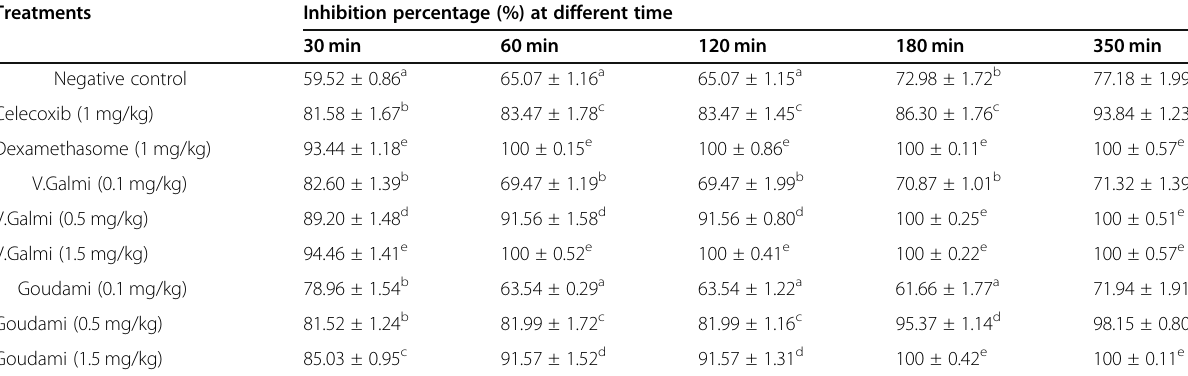
Table 6 Effect of onion extract on inhibition percentage in albinos rat edema induced by carrageenan